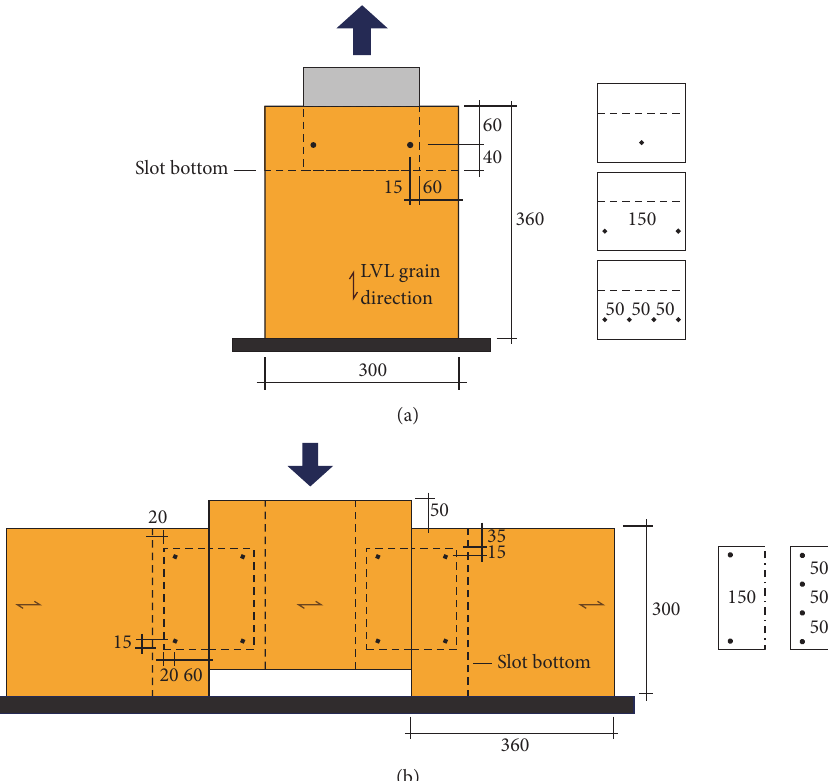
Figure 3: Test set-up for simulation of (a) vertical uplift force and (b) horizontal shear force (cf. Figure 11). Screw configurations shown to the right, distance to loaded end 60 mm. PlyBoard specimen 300 × 360 × 42 mm ( 𝑤 × ℎ × 𝑡 ), steel plate 180 × 160 × 3 ( 𝑤 × ℎ × 𝑡 ) for uplift and shear tests of quality S355, and frame screw 6.7 × 42 mm (see Figure 4).